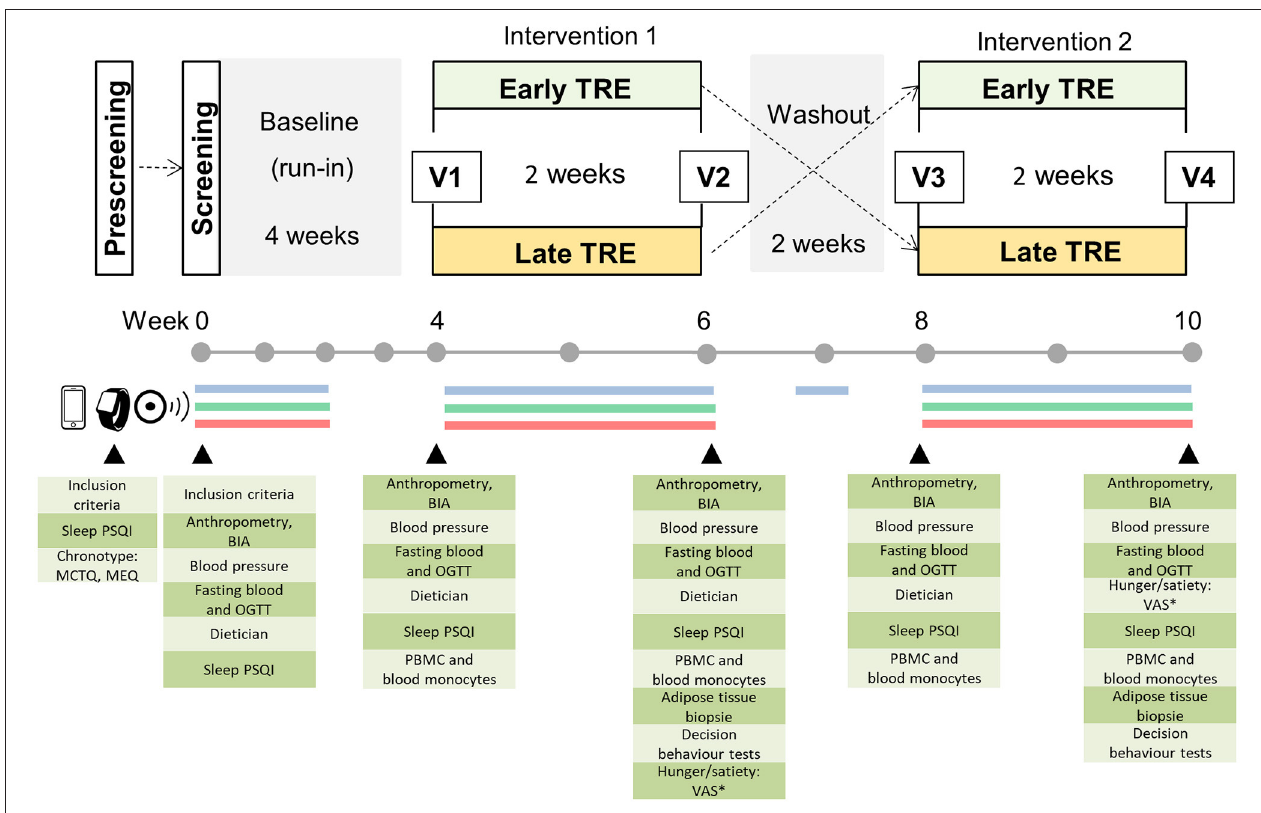
FIGURE 1 | Study design. Prescreening of potential participants is performed by phone and mail, and enrolled subjects are invited to the clinical research center for a screening examination. The cross-over study includes a 4-week baseline (run-in) and two 2-week dietary intervention periods separated by a 2-week washout phase. Blue line: assessment of eating pattern using a smartphone app or paper-based handwritten food and body weight diaries; green line: continuous glucose monitoring, red line: assessment of activity and sleep patterns by actigraphy and sleep diary for 14 consecutive days during the run-in (baseline period) and each intervention. In the washout phase, food intake monitoring is performed for 3 consecutive days. * Visual Analog Scale (VAS) is assessed at 8:00 and 20:00h on the day before visit 2 and visit 4; V, visit at the examination